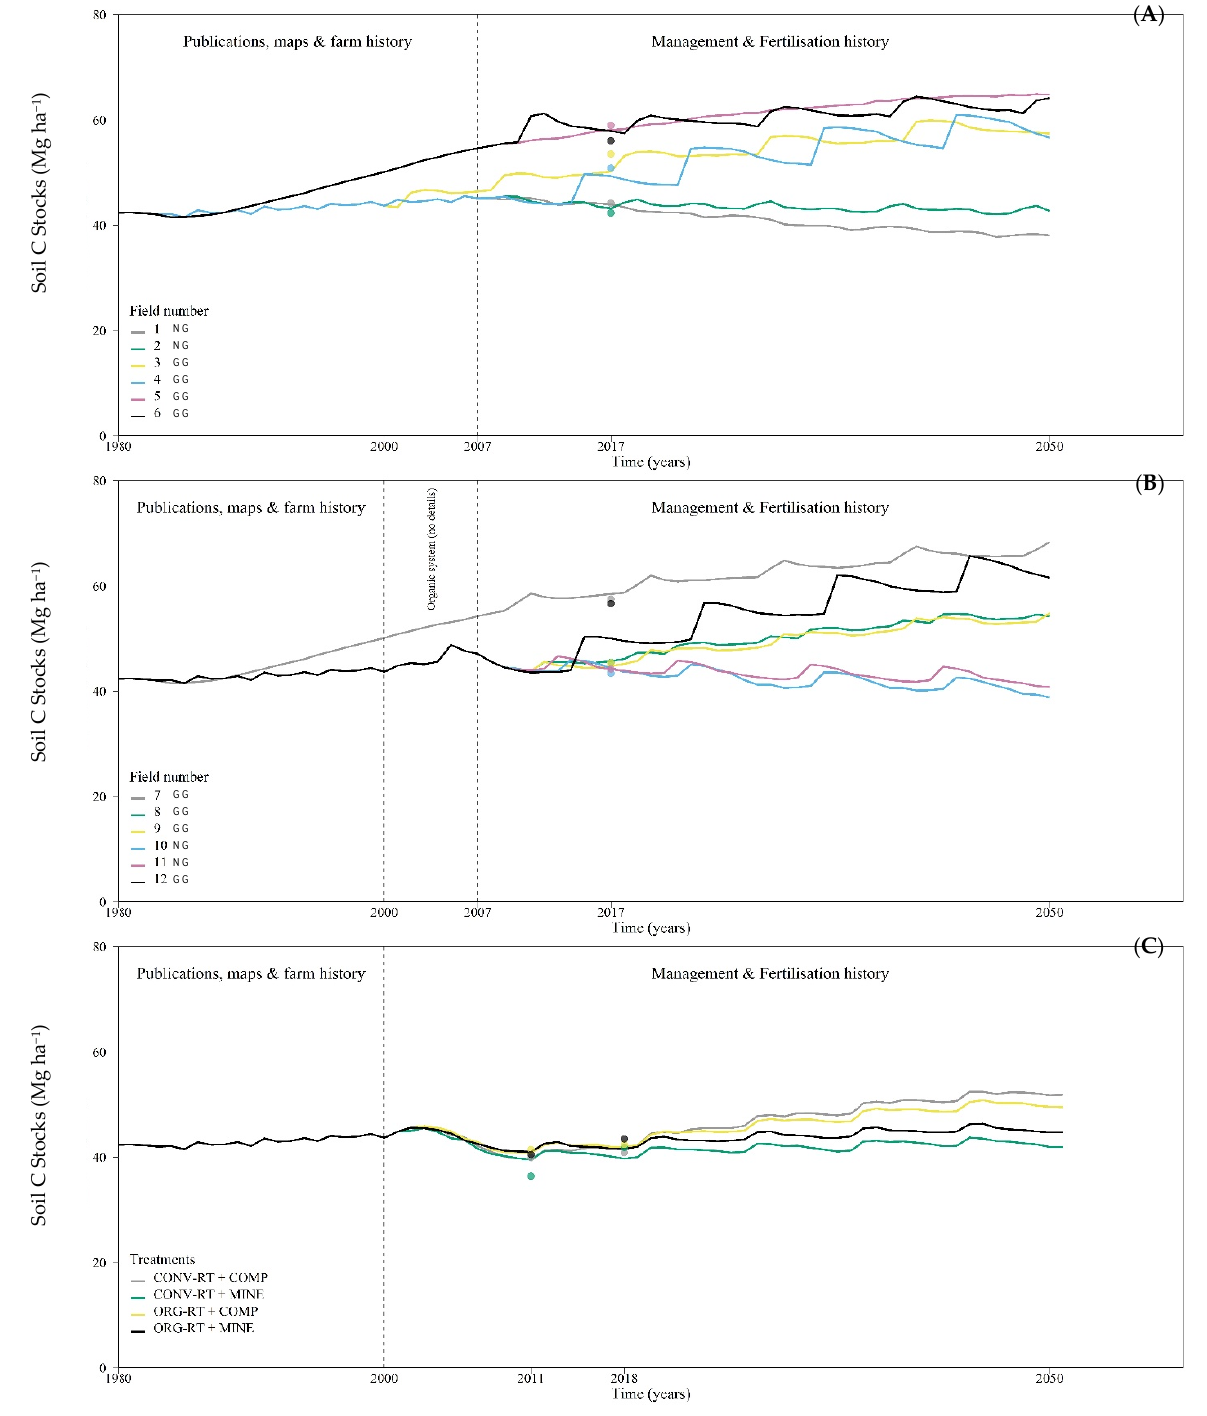
Figure 2. Long-term simulations of soil C stocks at 0–0.20 m depth of the farm-scale study in ( A ) conventional system, ( B ) organic system and ( C ) for the Nafferton Factorial Systems Comparison (NFSC) trial. Grazing regime represented by non-grazed—NG and/or grazed—GG. Treatments in the NFSC trial include crop rotation (conventional—CONV-RT and organic—ORG—RT) and fertility sources (mineral—MINE and compost—COMP). Dots represent measured mean soil C stock values in 2017 for A and B and in 2011 and 2018 for C.3.3 Soil C stock changes in the long-term simulations and hypothetical scenarios.